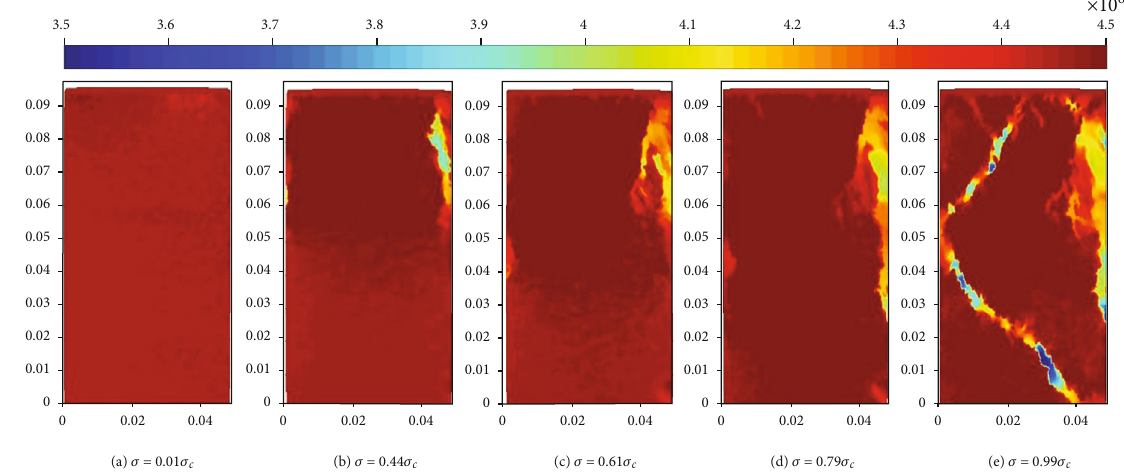
Figure 9: Pore pressure distribution under di ff erent stress levels in gas-containing